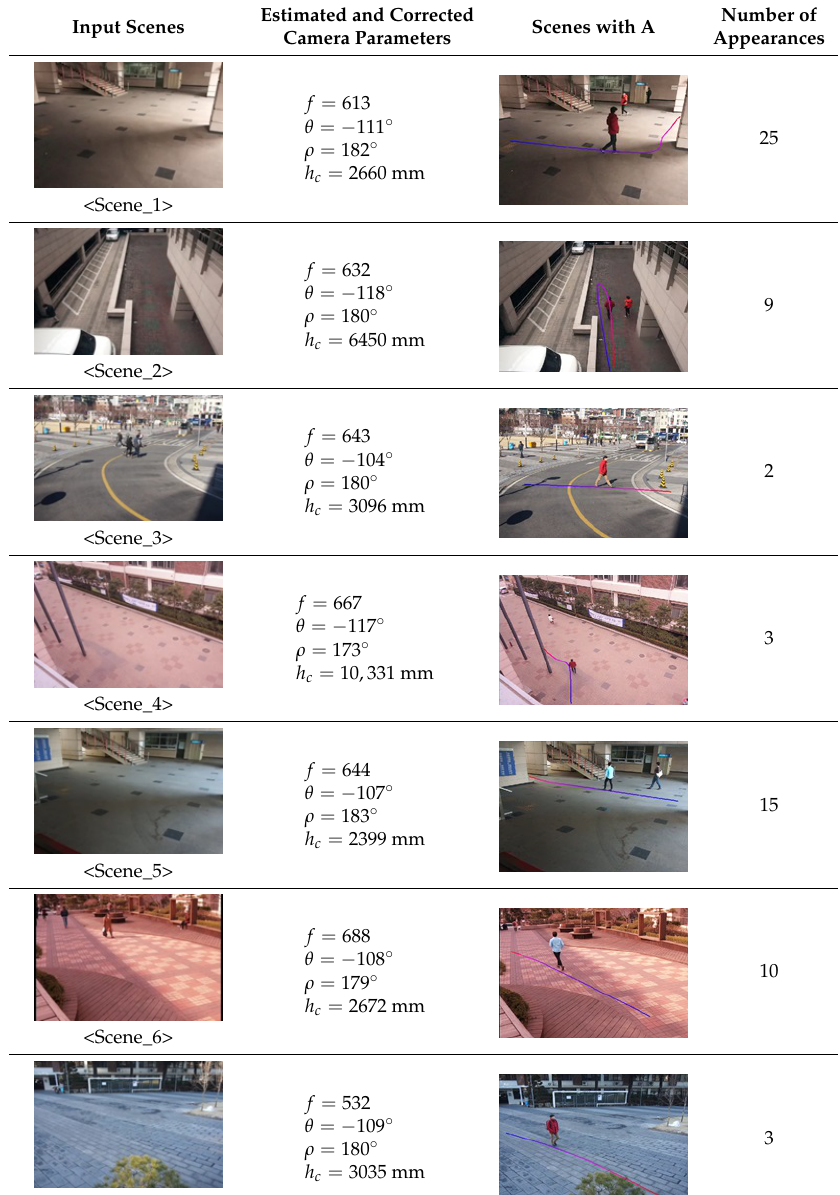
Table 2. Performance evaluation of scene